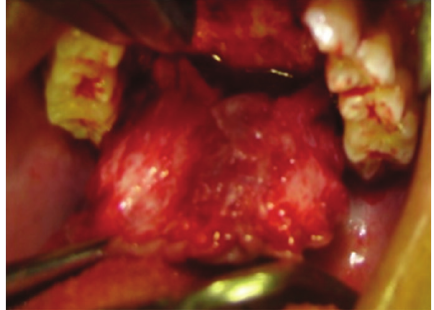
Figure 3: Intraoperative photograph showing excision of the lesion.